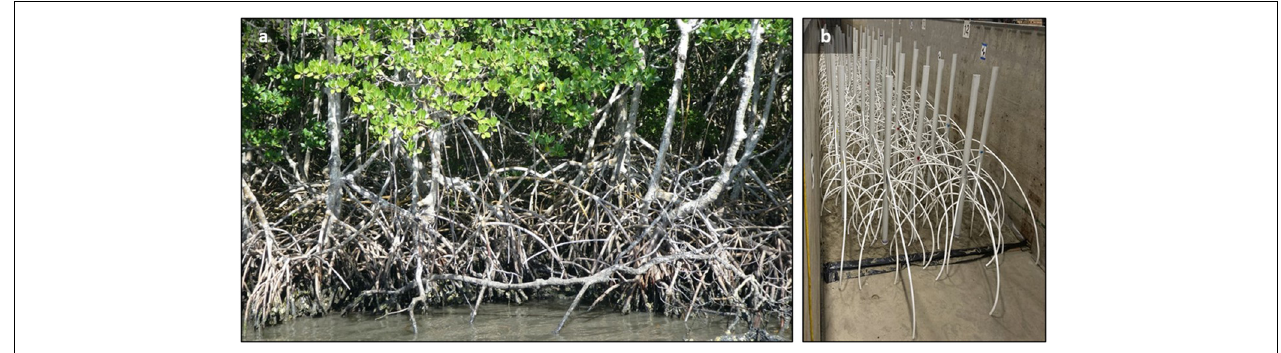
FIGURE 1 | (a) Intertwined trunk-prop root system of R. mangle in St. Lucie Inlet State Park, FL. (b) Physical model of Rhizophora sp. trunk-prop root